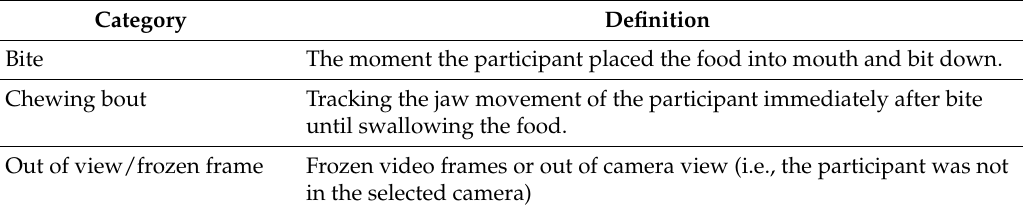
Table 2. Definitions of categories for food intake bout annotation.